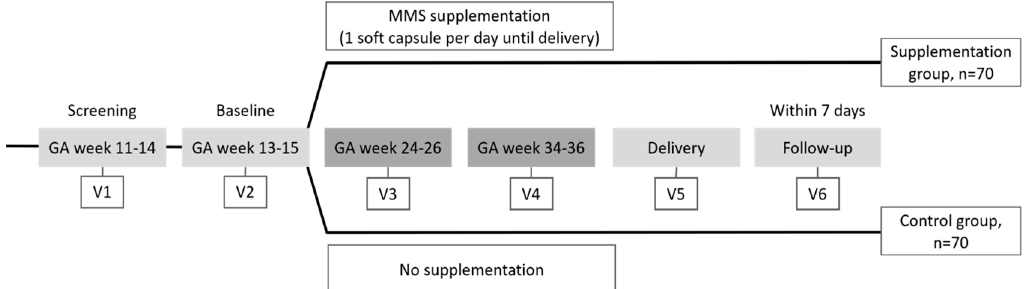
Figure 1. Study design. Visit 1 (V1, screening): pregnant women were screened for study eligibility and blood collection was performed. Visit 2 (V2, baseline): eligible women meeting the inclusion and exclusion criteria were randomized equally to one of the two study groups; nutritional status was assessed using a semi-quantitative FFQ. Visits 3 and 4 (V3 &V4, MMS supplementation or no supplementation): FFQ was administered and blood sampling took place—the red blood cell DHA